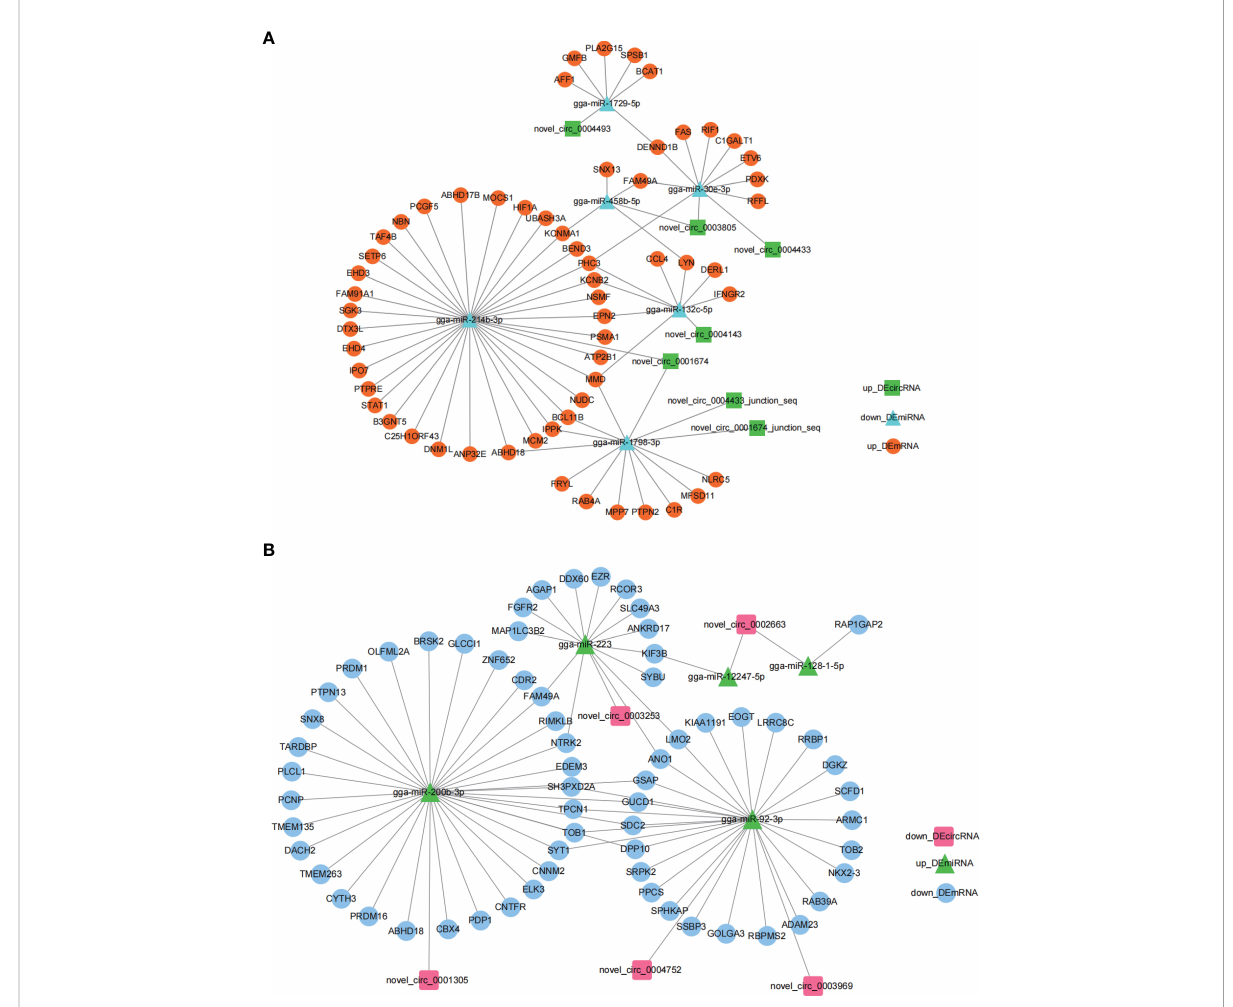
FIGURE 4 DEcircRNA - DEmiRNA - DEmRNA ceRNA regulatory networks generated by Cytoscape 3.7.2. (A) up_DEcircRNA - down_DEmiRNA - up_DEmRNA ceRNA networks generated using Cytoscape 3.7.2. (B) down_DEcircRNA - up_DEmiRNA - down_DEmRNA ceRNA networks generated using Cytoscape